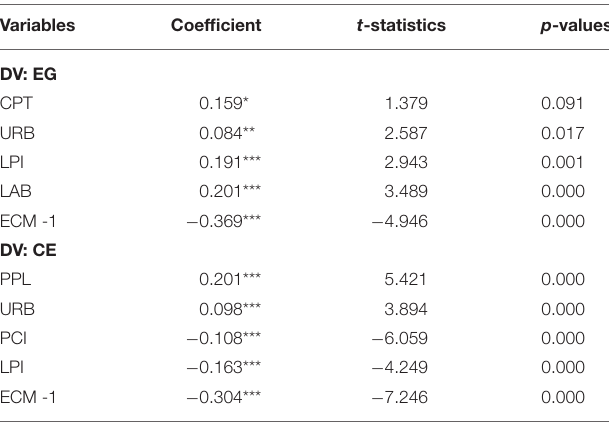
TABLE 6 | Results of Banerjee and Carrion-i-Silvestre (57) cointegration analysis. Sr. No.#